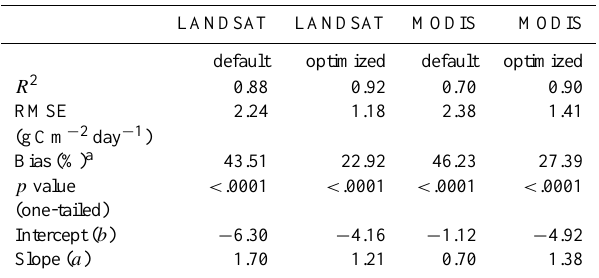
Table 4. Characteristics of linear regression analysis ( y = ax + b ) of 8-day averaged values of remotely sensed GPP versus that of EC- derived